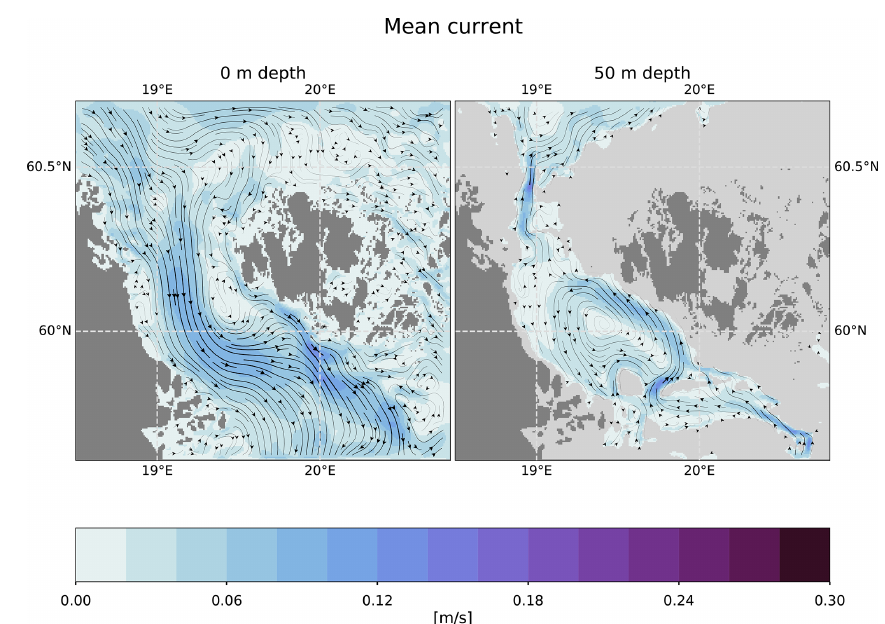
Figure 7. Modelled mean currents at the surface and 50m depth in 2013–2017.